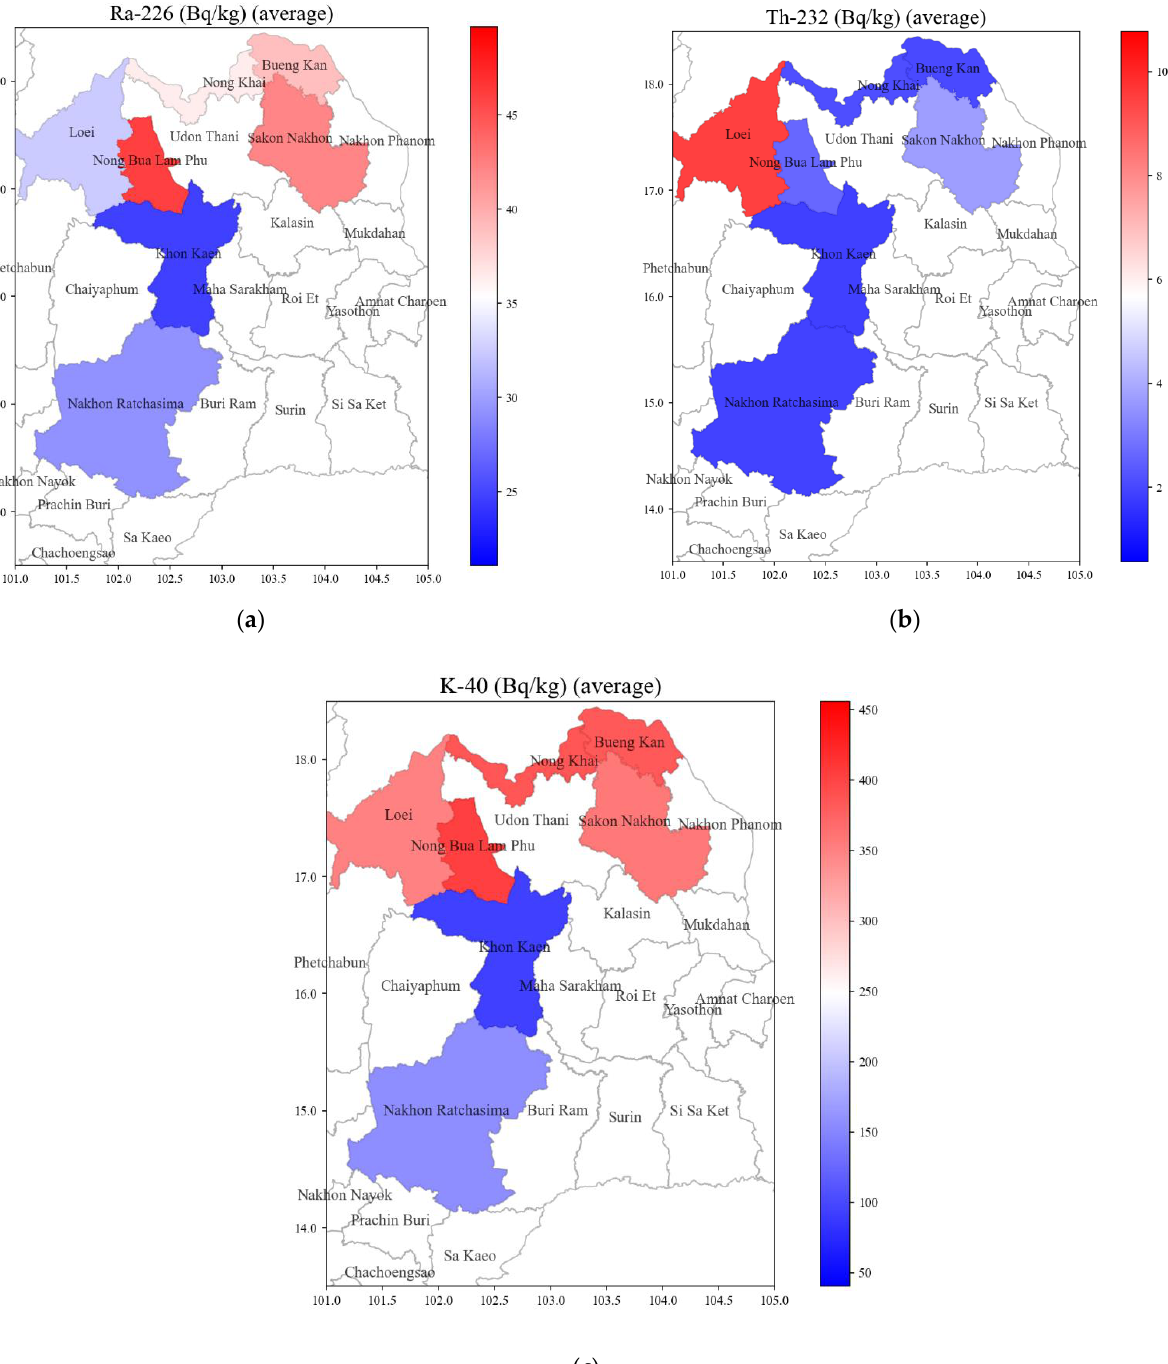
Figure 4. The activity concentrations of Ra-226 ( a ), Th-232 ( b ), and K-40 ( c ) in sand samples are shown in the